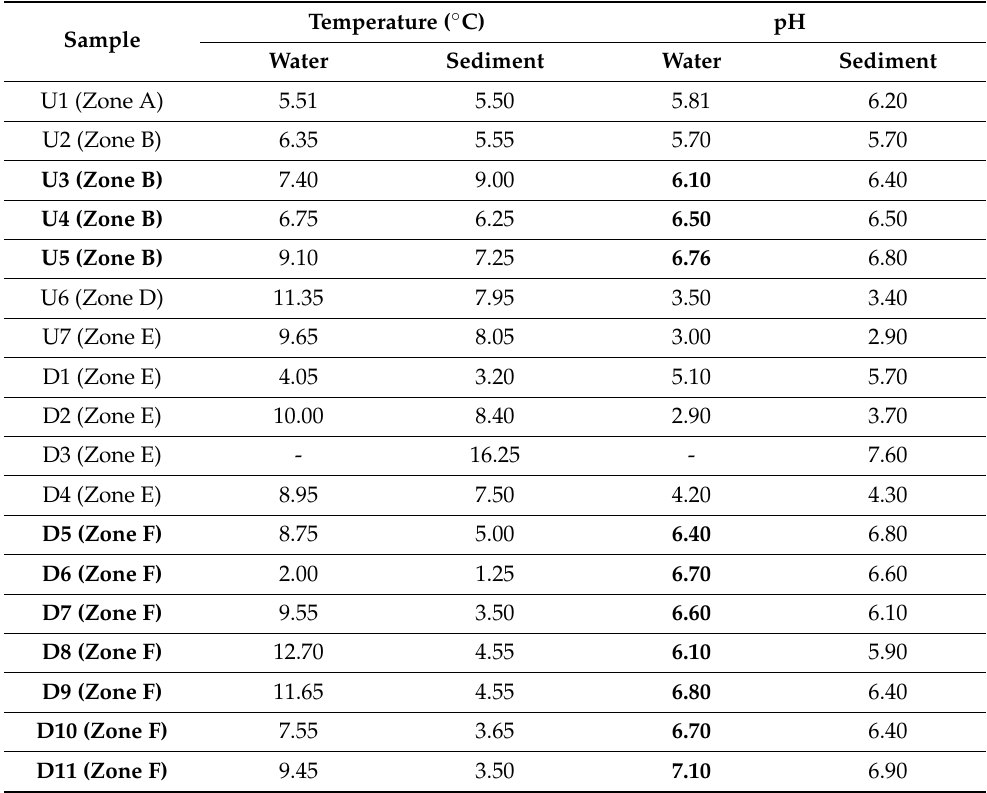
Table 3. The average pH and temperature at each sample location (acidic sites are denoted in normal text, more neutral are denoted in